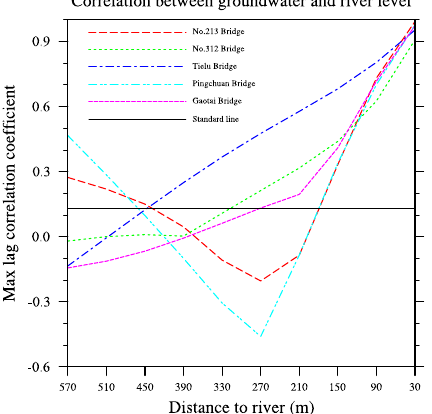
Figure 10. Maximum lag correlation coefficients between simu- lated groundwater tables across the left riverbanks and the river wa- ter levels at the five stations, and the standard line representing the value of correlation coefficient passing the Student’s t test with a confidence level of